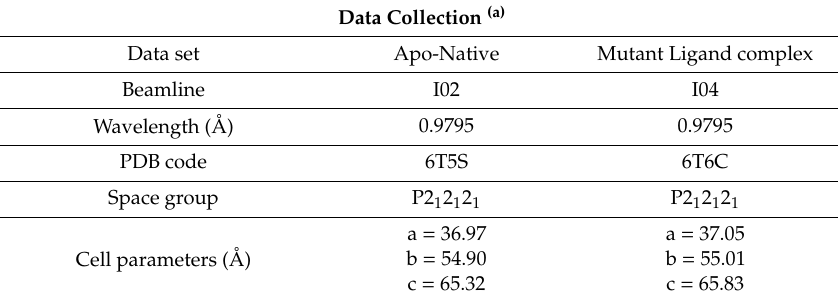
Table 1. Crystallographic